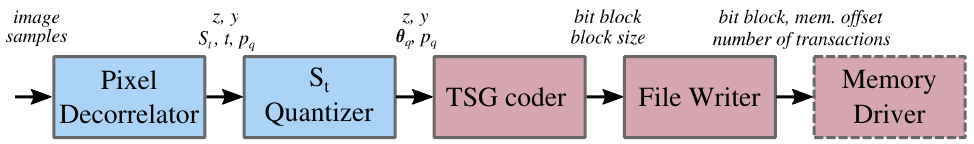
Figure 2. LOCO-ANS hardware high-level block diagram. In blue, modules running at the lower frequency, and in red, modules running at the higher